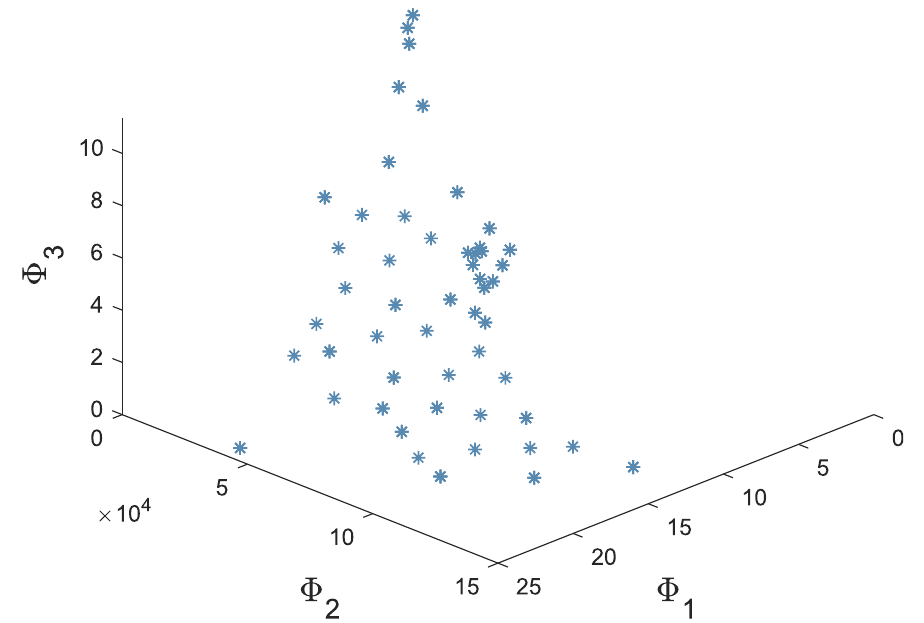
Figure 8. Pareto front in terms of the three objective functions for a feasible solution for the example in Figure